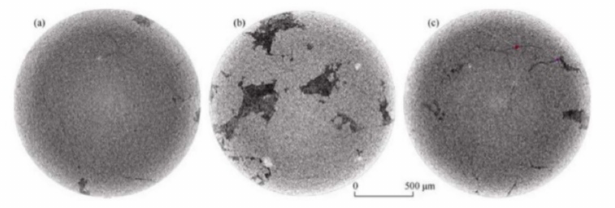
Figure 15. Two-dimensional µ CT scans, Yanchang sandstone reservoir [77].